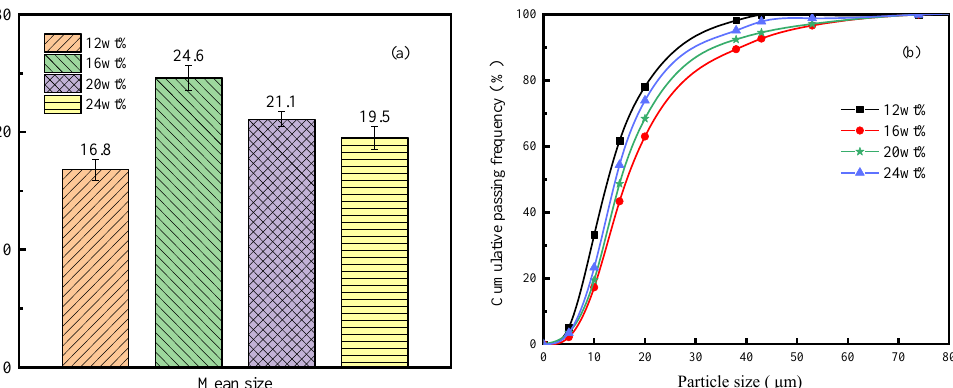
Figure 4. Effect of anthracite dosage on size characteristics of ferronickel particles: ( a ) mean size; ( b ) cumulative passing frequency distribution. ( b ) cumulative passing frequency